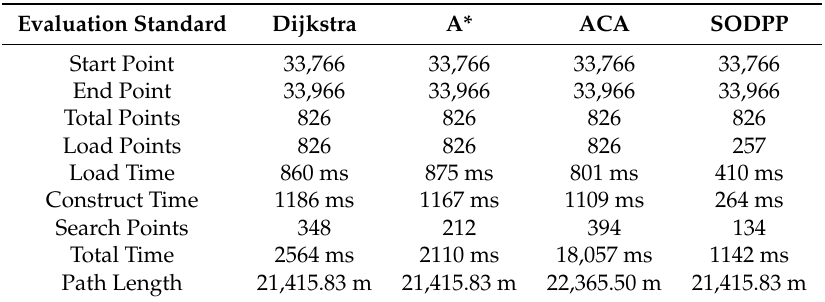
Table 4. Comparison of results for Experiment